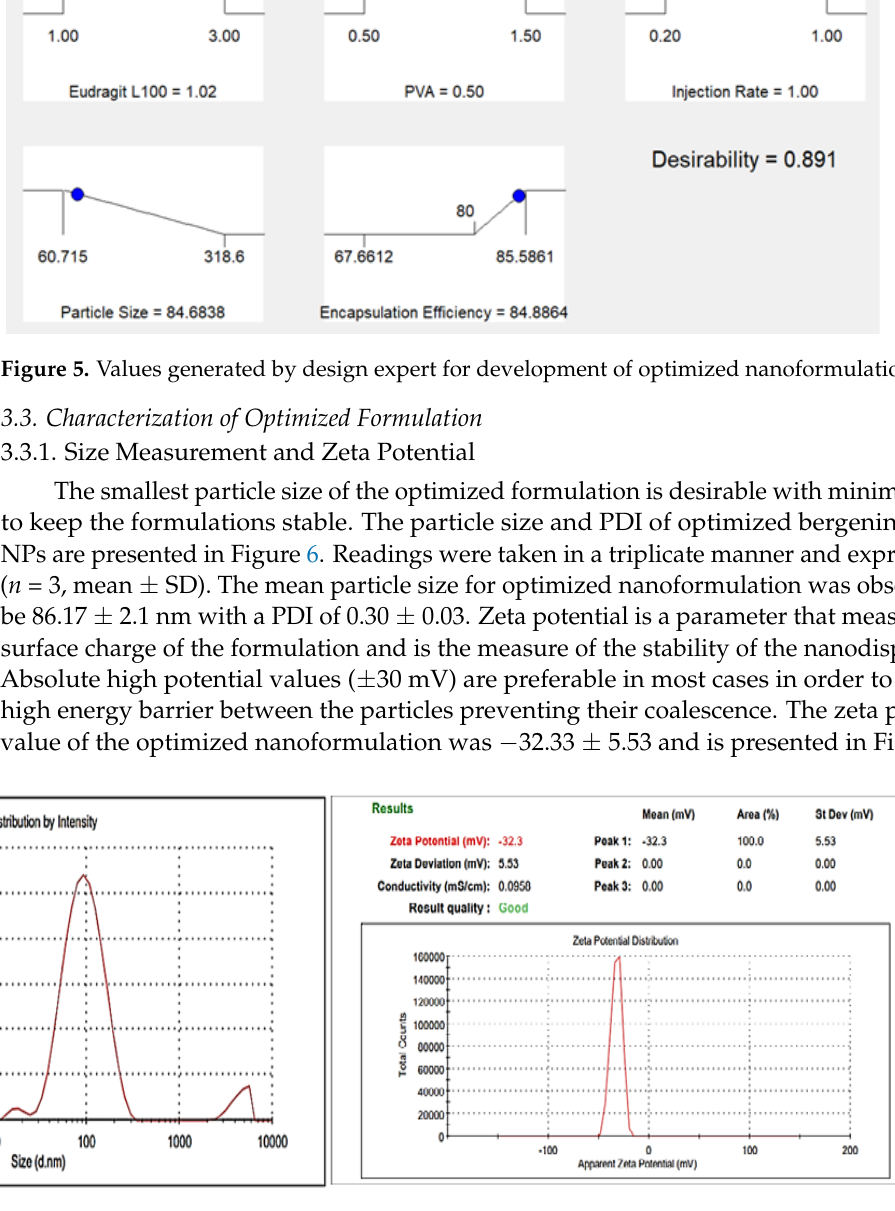
Figure 5. Values generated by design expert for development of optimized nanoformulation.